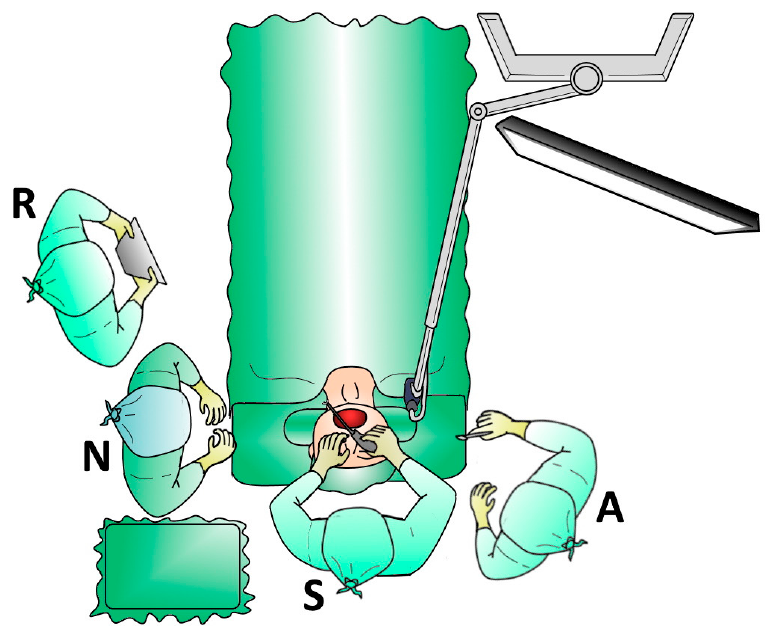
Figure 1. Operating theater setting for barbed pharyngoplasty using the 4K three-dimensional exoscope system (VITOM 3D): Surgeon (S), Assistant (A), Nurse (N), Resident (R).